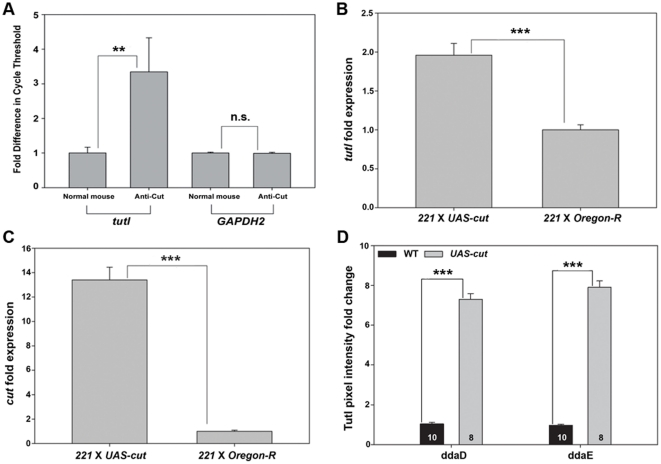
Cut specifically binds to the tutl promoter and positively regulates Tutl expression.(A) qPCR analysis reveals a significant 3.35 ± 1.26 fold increase in tutl genomic DNA in chromatin immunoprecipitated with a monoclonal anti-Cut antibody as compared to the normal mouse IgG control (n = 4). As a negative control, GAPDH2 levels are unchanged between anti-Cut and mouse IgG preparations (n = 4). (B–C) qPCR of RNA isolated from either wild-type (221 X Oregon-R) or Cut overexpressing (221 X UAS-cut) class I da neurons shows that in Cut overexpressing class I da neurons tutl mRNA is significantly 1.96 fold overexpressed compared with wild type class I neurons (B) (n = 4). cut mRNA was present at a significant 13.39 fold increase in Cut overexpressing class I da neurons compared with wild-type (C) (n = 4). (D) Quantitative mean pixel density analyses of Tutl protein expression revealed a 7–8 fold increase in Tutl immunoreactivity levels in class I neurons overexpressing UAS-cut (n = 8) relative to wild-type controls (n = 10). Statistically significant p values are reported on the graphs as follows (** = p<0.01; *** = p<0.001; n.s. = not significant). Genotypes: (B,C) 221 X Oregon-R corresponds to GAL4221,UAS-mCD8::GFP/+; 221 X UAS-cut corresponds to UAS-cut/+;GAL4221,UAS-mCD8::GFP/+. (D) WT corresponds to GAL4221,UAS-mCD8::GFP/+; UAS-cut corresponds to UAS-cut/+; GAL4221,UAS-mCD8::GFP/+.